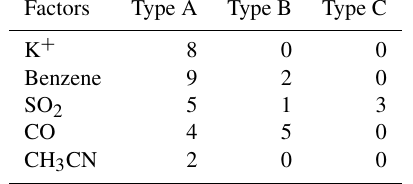
Figure 8. The max correlation coefficient between particulate chlo- ride and a selected parameter matrix (including K + , benzene, SO 2 , CO, acetonitrile (CH 3 CN)) on each day. The labeled number repre- sents the days the event occurred; the dashed line denotes the thresh- old of 0.5 (39 valid days out of 46 in total). The cross means the cor- relation coefficient between Cl − and Na + is larger than the max.